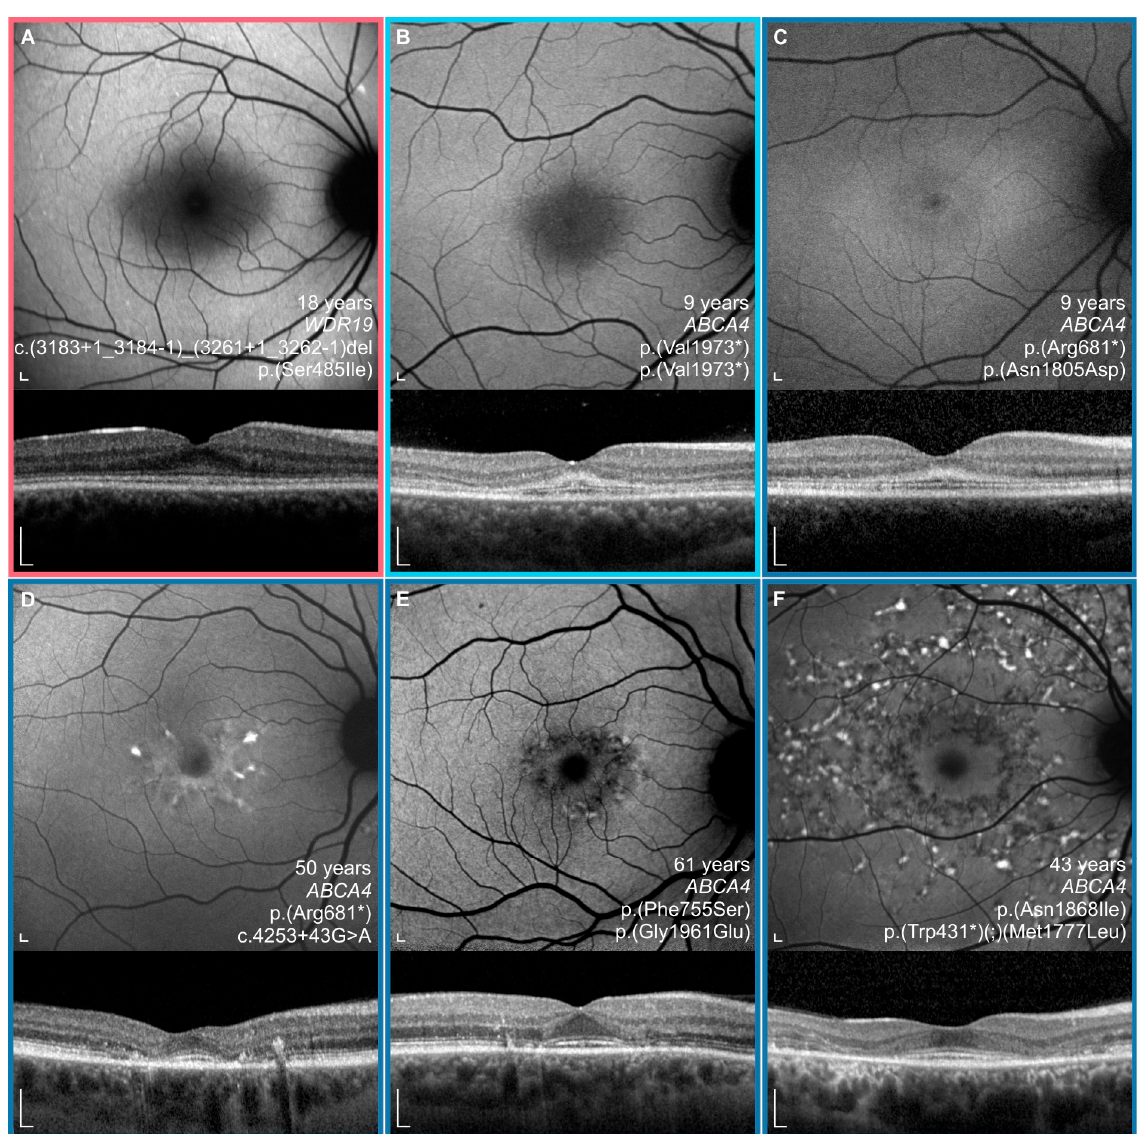
Figure 4. Characteristics of a WDR19 patient ( A ) and ABCA4 patients ( B – F ) and with foveal sparing. Note a relatively large extent of foveal preservation in the WDR19 patient. WDR19 patient is encircled with red ( A ), double null ABCA4 patient with light blue ( B ) and ABCA4 patients with other genotypes with dark blue ( C – F ). Note the hyper-reflectivity at the level of the external limiting membrane (ELM)/outer nuclear layer (ONL) in the WDR19 patient and two ABCA4 patients ( B , C ). Note also the relatively dark fovea of the WDR19 patient and two of the ABCA4 patients ( E , F ). Scale bars: 200 µm.